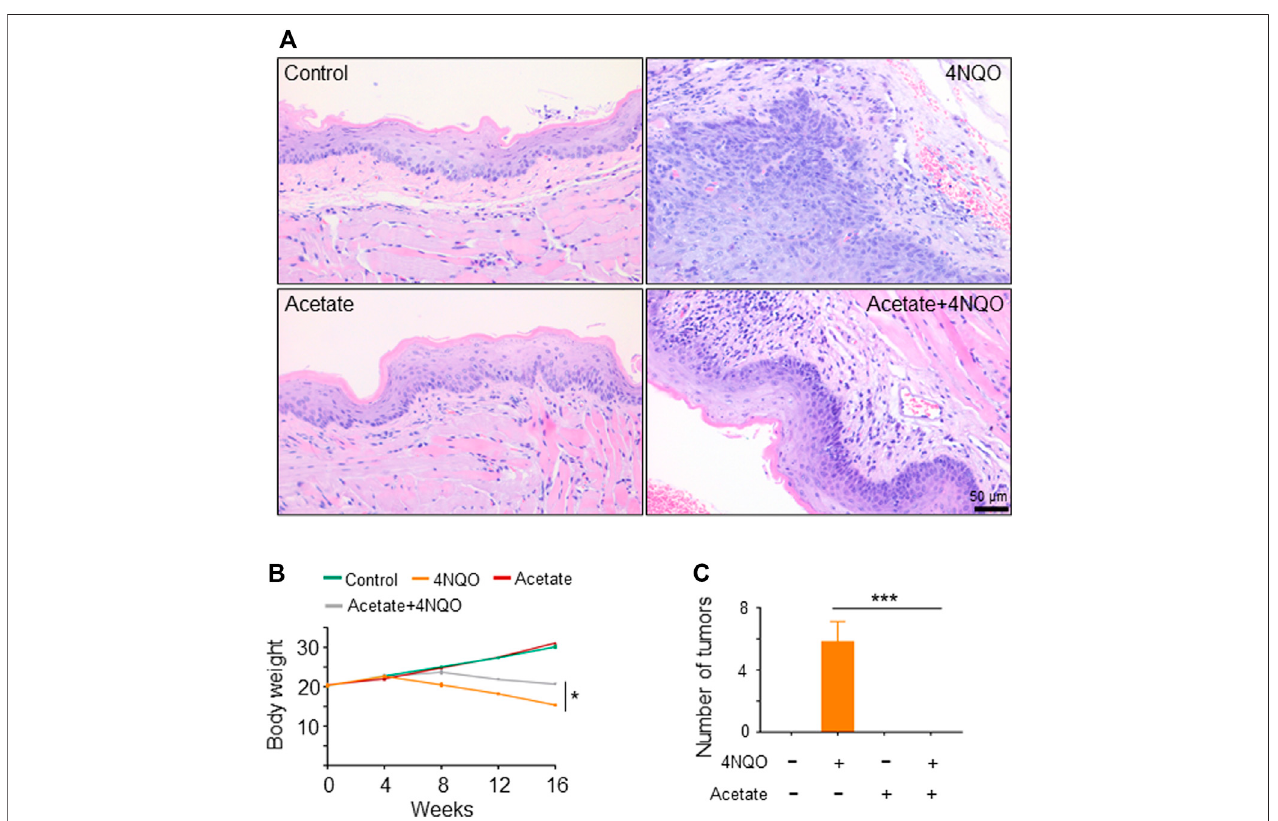
FIGURE 5 | Metabolites of Lactobacillus, in particular short-chain fatty acids (SCFAs), contribute to Lactobacillus -induced anti-tumor effects. SPF BALB/C mice were treated with 150 mM acetate and/or 4NQO for 4 months. After the treatment, the mice were sacri fi ced and the glossopharyngeal tissue of mice was collected for histological staining. (A) HE staining ofglossopharyngeal tissue. (B) Bodyweight ofmice. (C) Number oftumors in each mouse. Datarepresent mean ±SEM. * p < 0.05, *** p < 0.001, n = 5, compared with 4NQO.